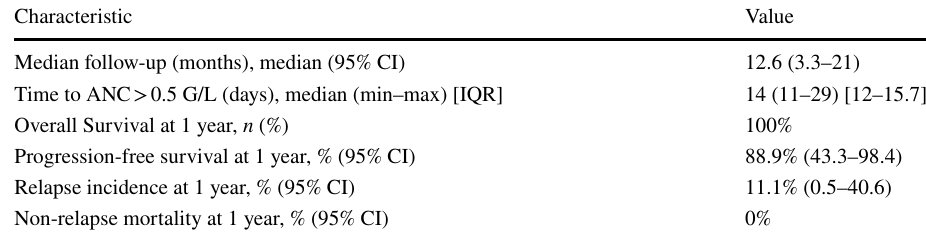
Table 2 Outcome after second salvage